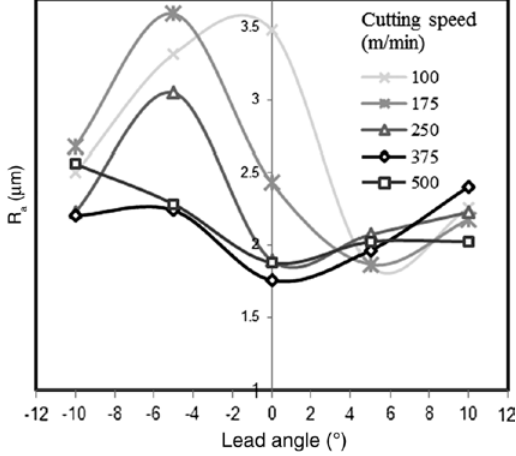
for different a